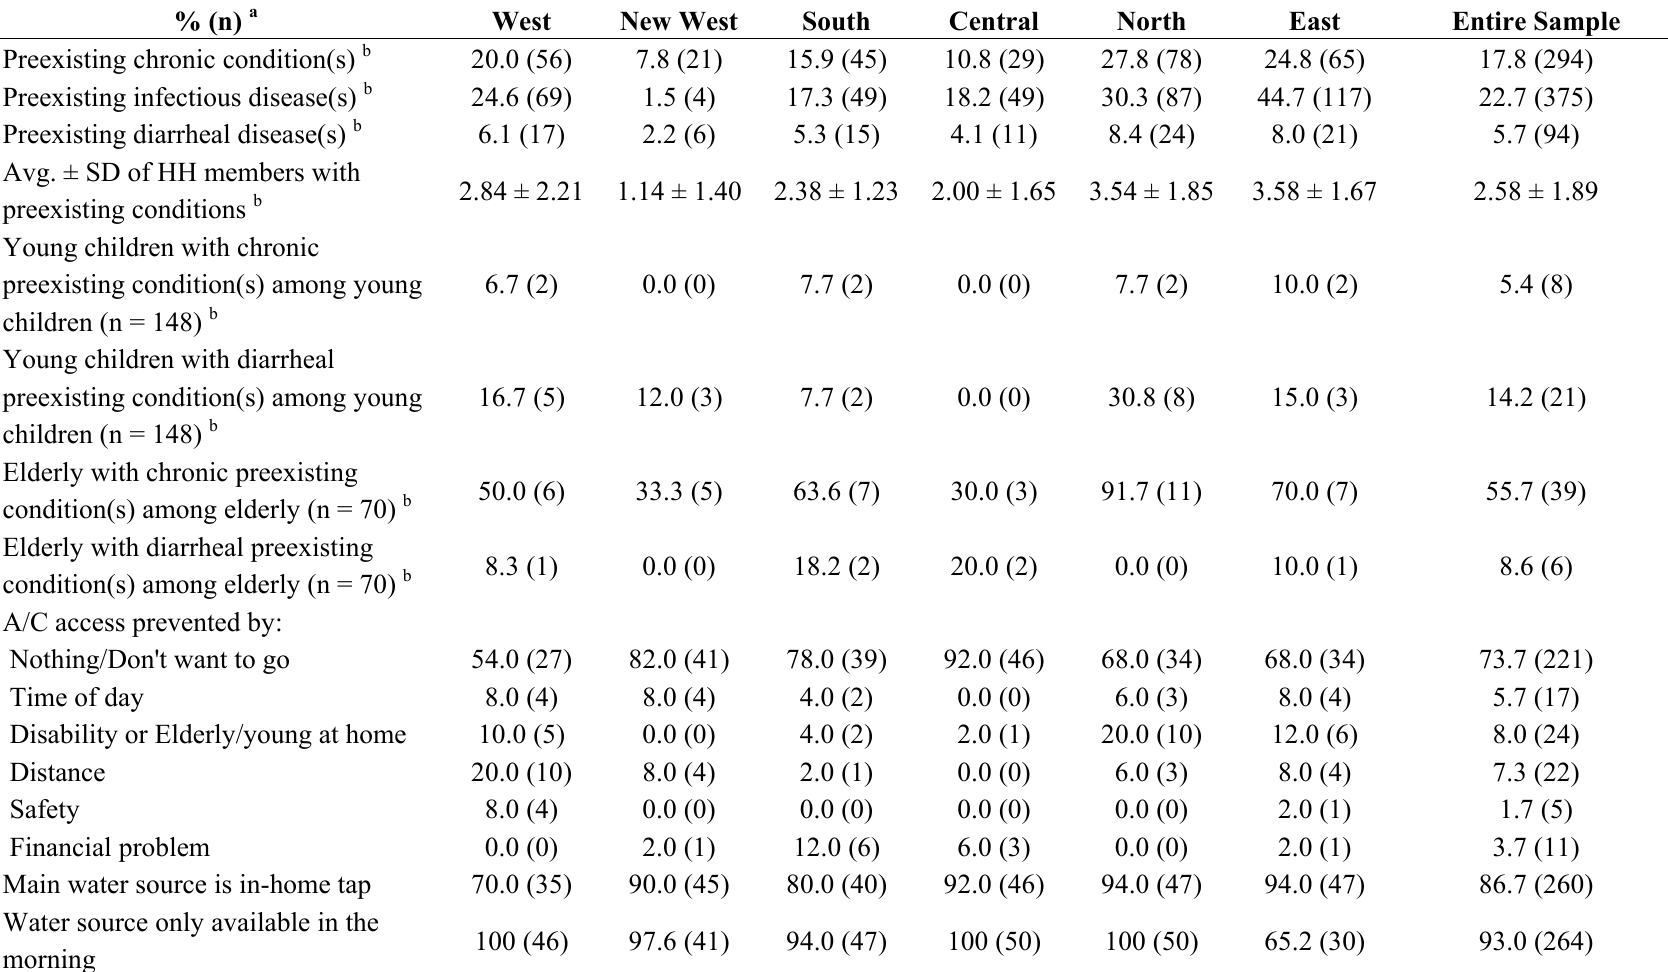
Table S2. Individual (N = 1,650) and household (N = 300) susceptibility factors among residents of Ahmedabad slums across six city